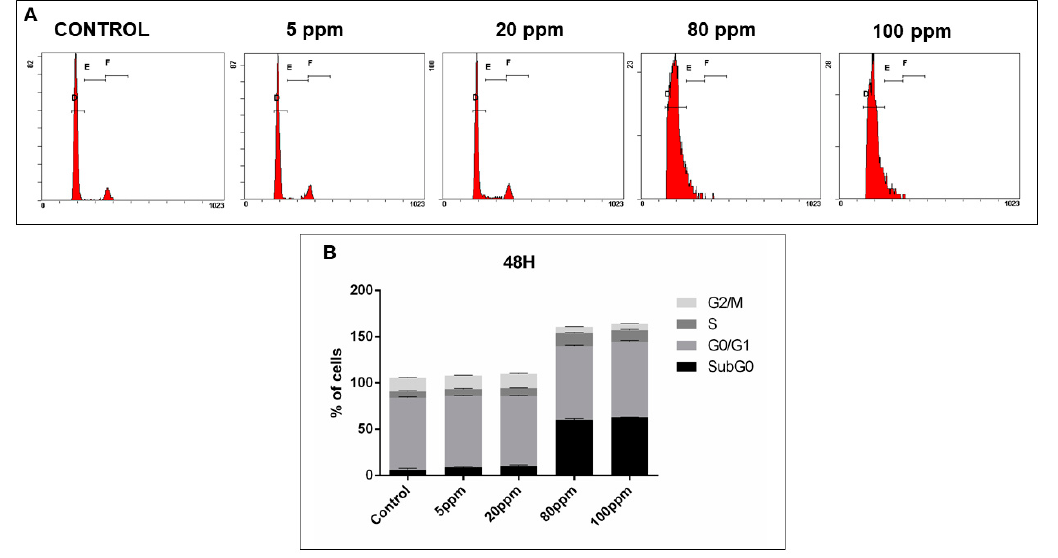
Figure 11. Cell cycle analysis, of LNCaP cells treated with different concentrations of AgNPs for 24 h, assessed using a PI stain and flow cytometry. ( A )—Representative DNA histograms. ( B )—Quantitative analysis of PC-3 cells AgNPs treated. Data is expressed as mean ± SEM.